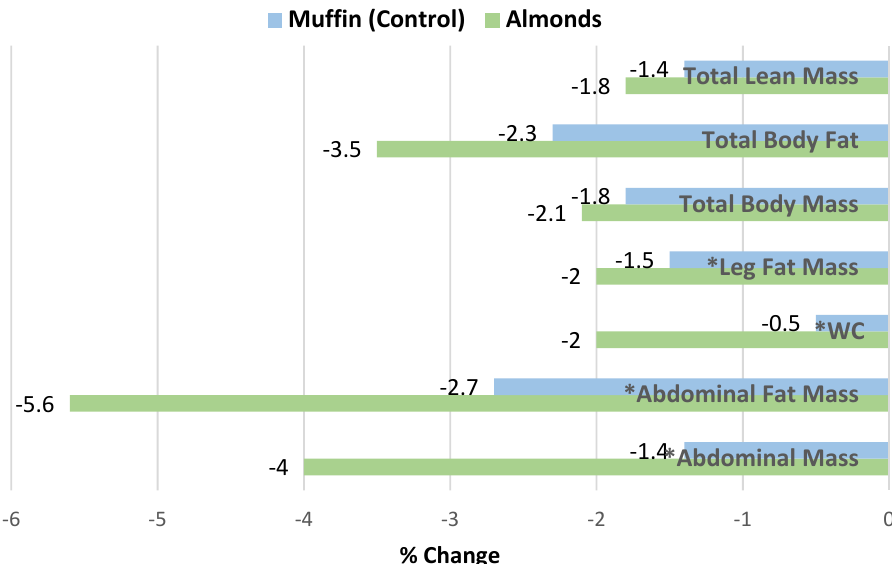
Figure 14. Changes in % body mass and composition outcomes for raw almonds (42.5 g /day) compared to muffin control in identical heart-healthy diets from baseline to 6 weeks (* p < 0.02) [53].